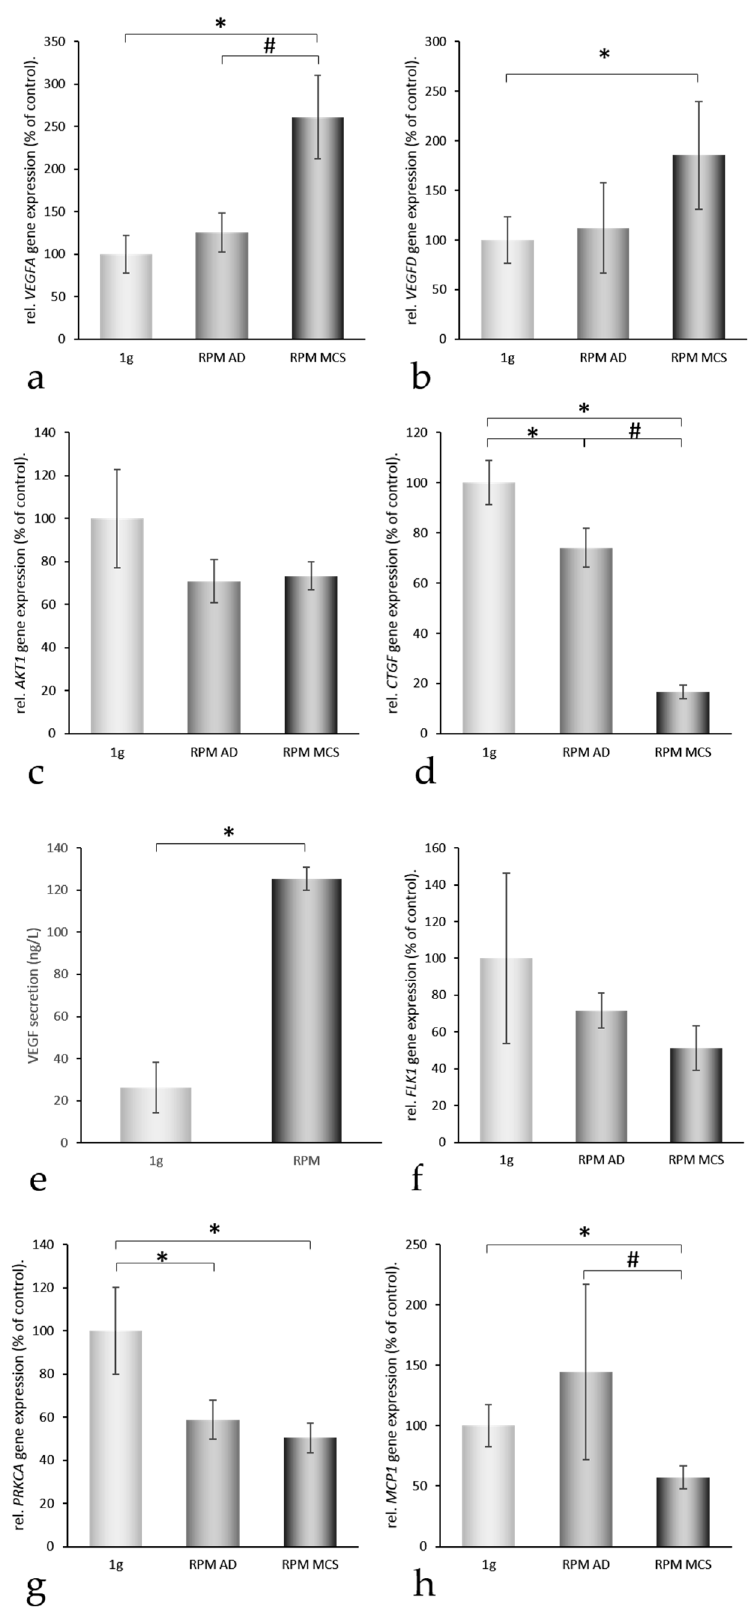
Figure 4. Quantitative real-time PCR of genes of interest II and VEGF secretion. After 24 h, 1 g -control, RPM-adherent (AD) and RPM-multicellular spheroids (MCS) were analyzed for their VEGFA ( a ); VEGFD ( b ); AKT1 ( c ); CTGF ( d ); FLK1 ( f ); PRKCA ( g ); and MCP1 ( h ) gene expression levels. In addition, VEGF secretion into the culture medium was determined ( e ) * = p < 0.05 vs. 1 g ; # = p < 0.05 vs. RPM AD.